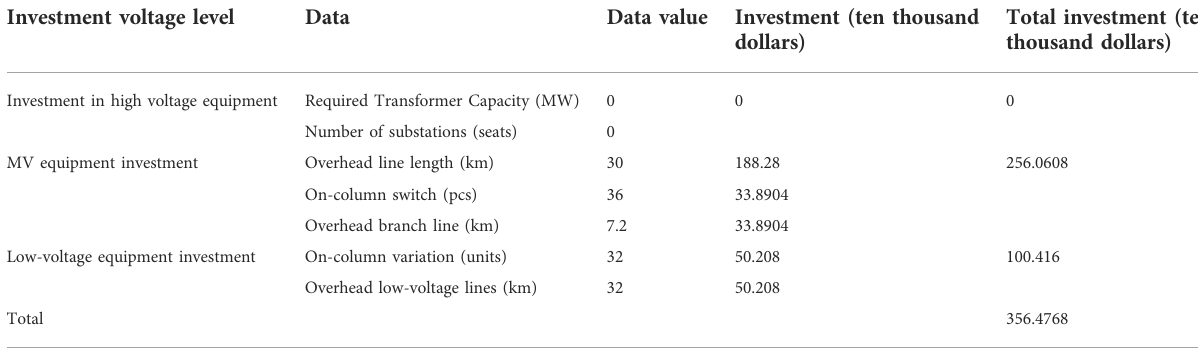
TABLE 7 Save investment due to interruptible load response in 2022.